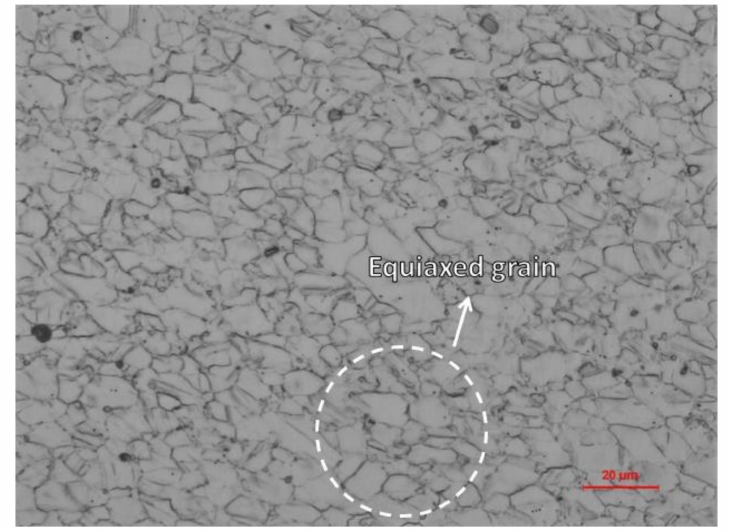
Figure 1. Optical micrograph of Inconel 625.